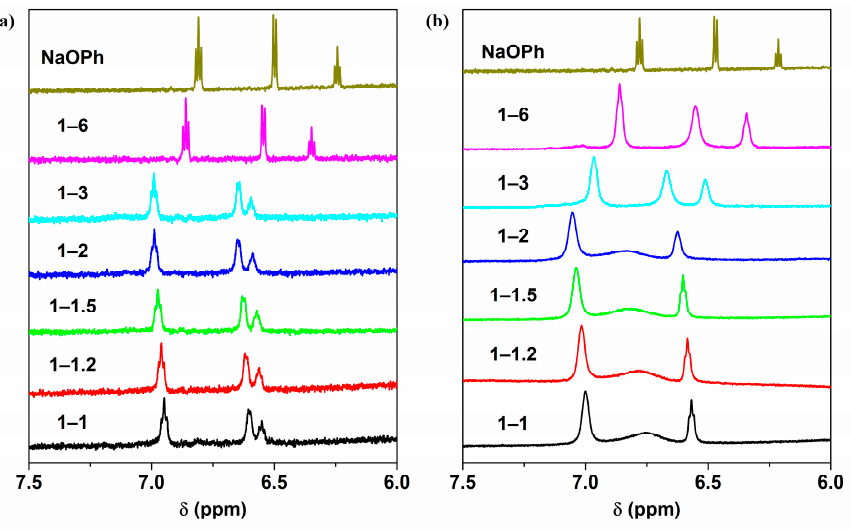
Figure 3. 1 H NMR characterizations on the reactions of ( a ) YCl 3 -nNaOPh and ( b ) LaCl 3 -nNaOPh (n = 1–6) with the increase in molar ratio of NaOPh, respectively.